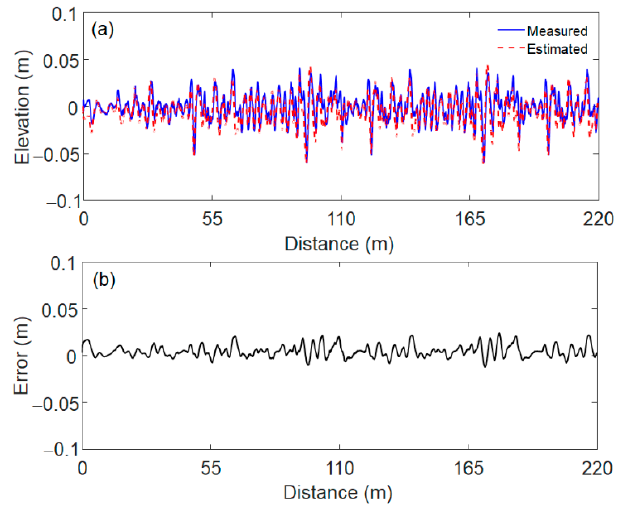
Figure 8. Simulation result of unknown road roughness input; ( a ) estimation of road roughness input, ( b ) estimation error between measured and estimated road roughness.